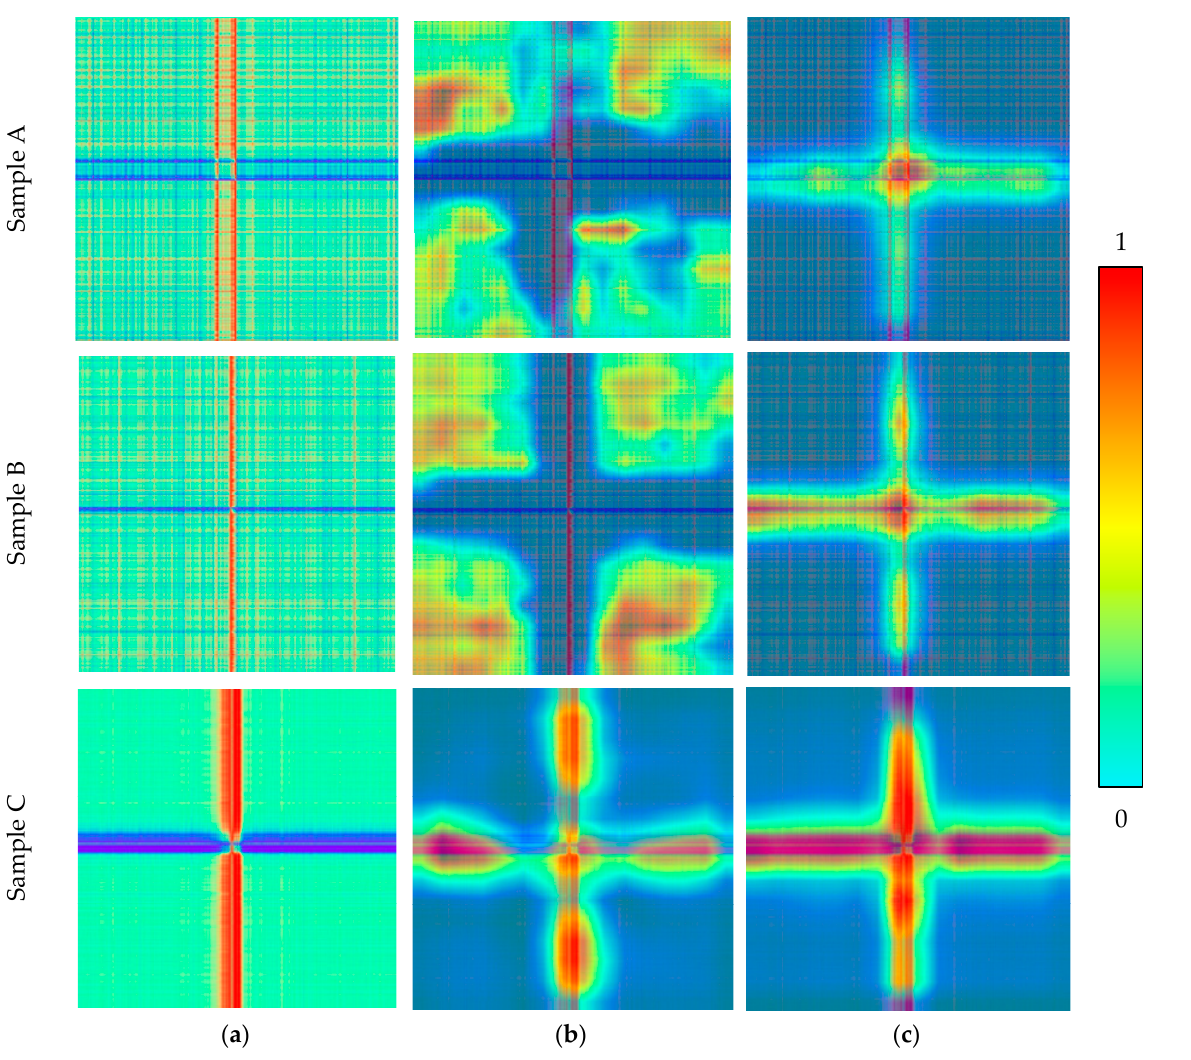
Figure 10. Class Activation Maps for GADF Encoded Graphs for Different Models: ( a ) Original image; ( b ) EfficientNet-B0; ( c ) CA ‐ EfficientNet ‐ B0.